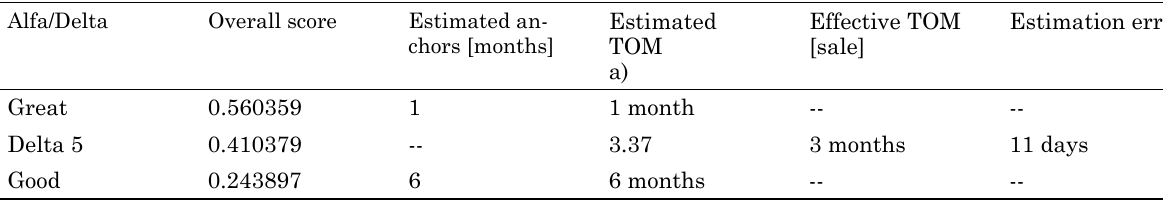
Table 7. Estimated and effective/observed TOM for Delta 5